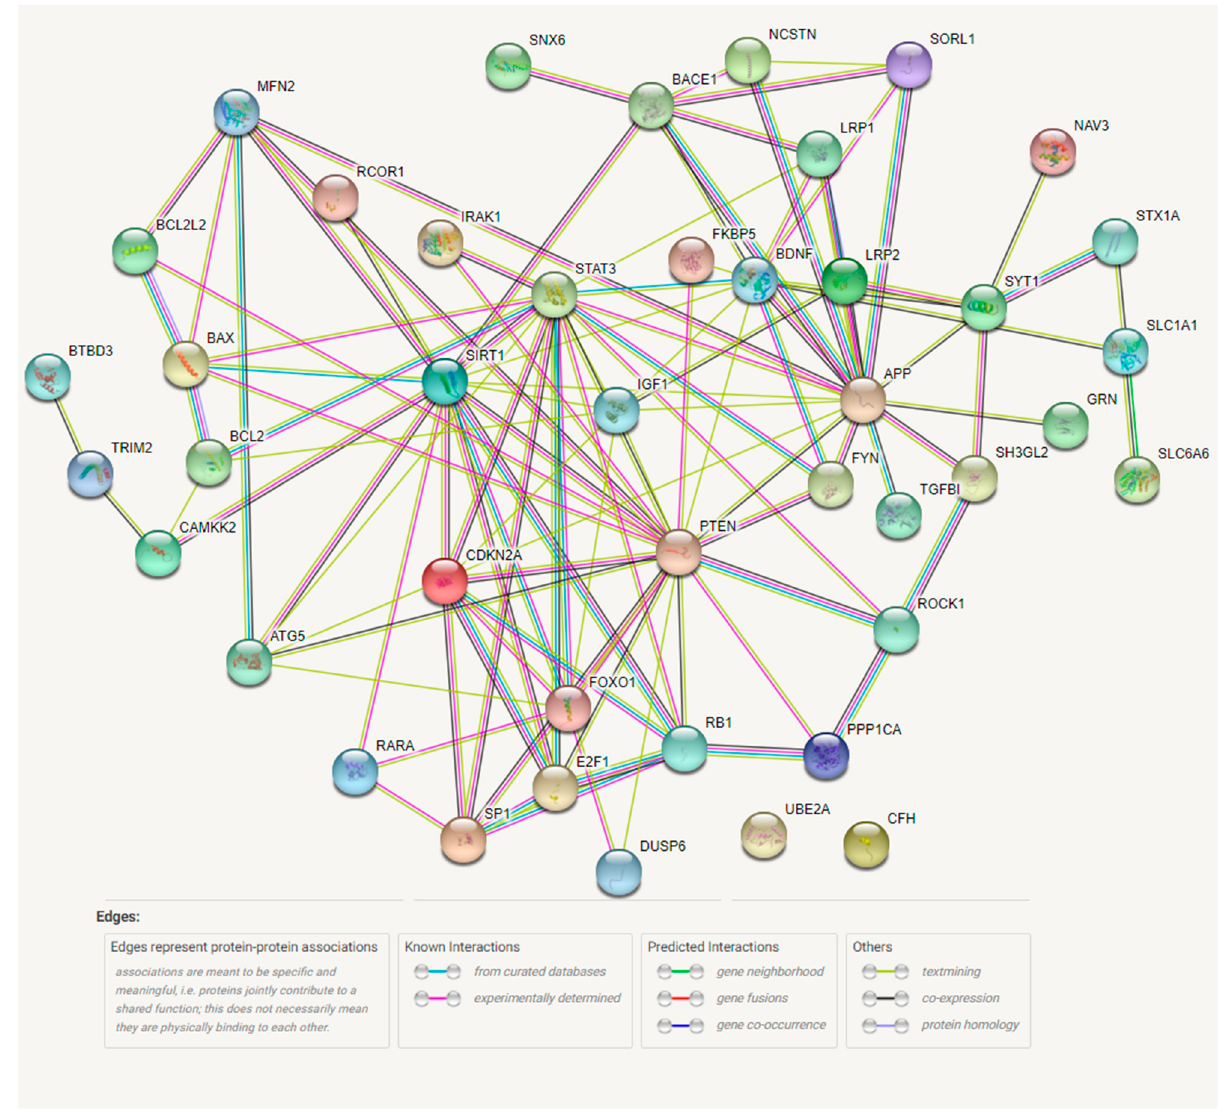
Figure 3. Protein–protein interaction network of 43 AD-associated miRNA targets using STRING software. The colors of connections between nodes represent the type interaction between the two proteins. The most reliable of these connections are “known interactions” from curated databases and experiments. Common gene neighborhoods, fusions, and co-occurrences as well as textmining, co-expression, and protein homology are considered less reliable connections and tend to require independent verification. Table 2. Results of the pathway enrichment analysis using mirPath tool. The table includes pathways associated with AD in previously published literature. A total of 37 AD-associated miRNAs were enriched in 68 pathways. This table includes 44 pathways, which were associated with AD in previously published literature. The PMID (Reference) column includes references to publications associating the KEGG pathway with AD